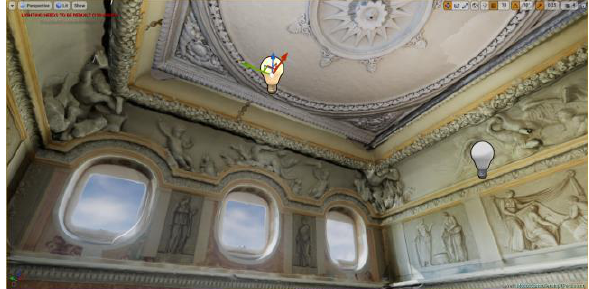
Figure 8. Example of additional lighting placement inside Big Hall chamber.